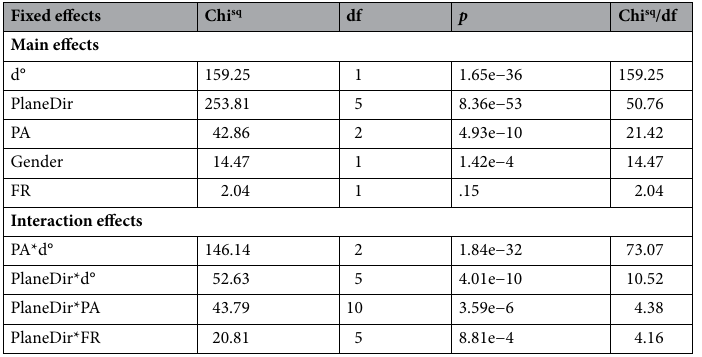
Table 1. Analysis of deviance table (Type II tests) of main effects and interaction effects (order-one interactions; *) in the selected model of MR task performance (measured as the natural logarithm of the response time; log RT). This analysis covered: d° (degrees of the rotation to be imagined), PlaneDir (plane and direction in which the rotation was performed), PA (physical activity of the subjects), Gender (sex of the subjects), FR (frame of reference used by the subjects to perform the MR task). The Table also shows, for each possible main effect and each statistically significant interaction effect, Chi-squared statistics (Chi sq ), degrees of freedom (df), p -value (where p is the probability that a Chi-squared distribution with a given df is superior to the observed Chi sq ) and a statistic (Chi sq /df) in order to stress the importance of the various effects (the higher the ratio, the more important the effect 39 ).